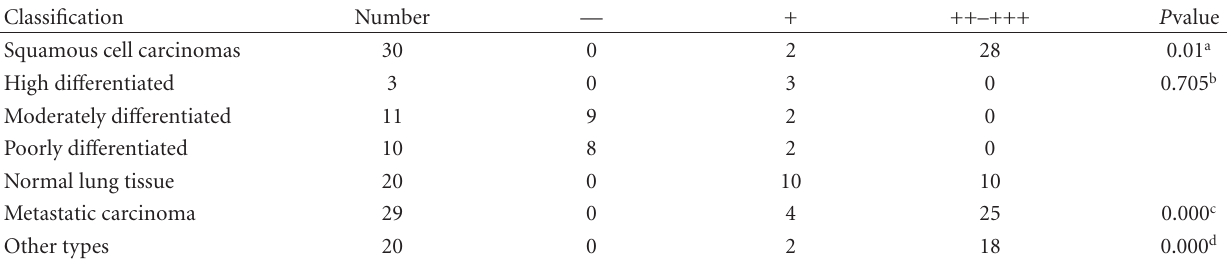
Table 5: S100A9 expression in various tissues by